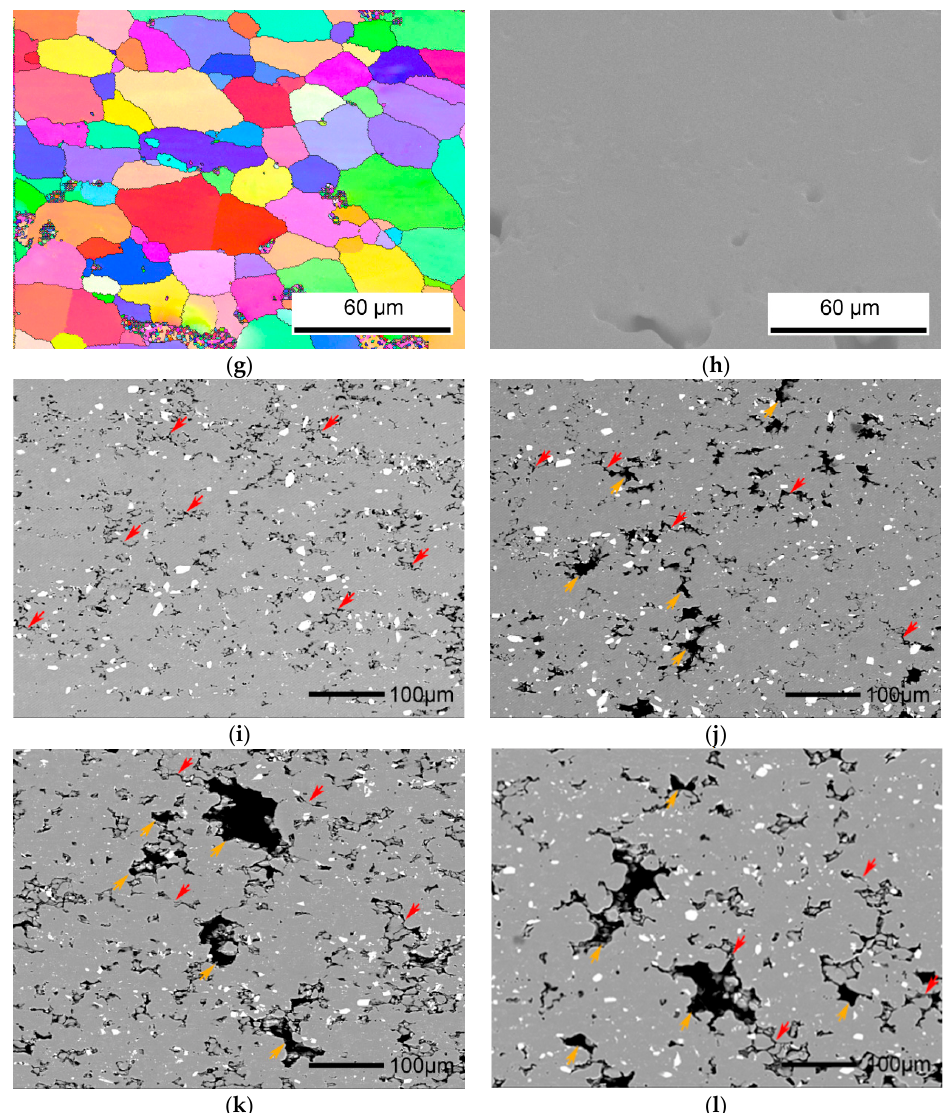
Figure 8. The Grain structures and the superplastic fracture morphologies at initial strain rate 1 × 10 − 3 s − 1 with different temperatures: 400 °C ( a , b , i ), 450 °C ( c , d , j ), 500 °C ( e , f , k ) and 550 °C ( g , h , l ).